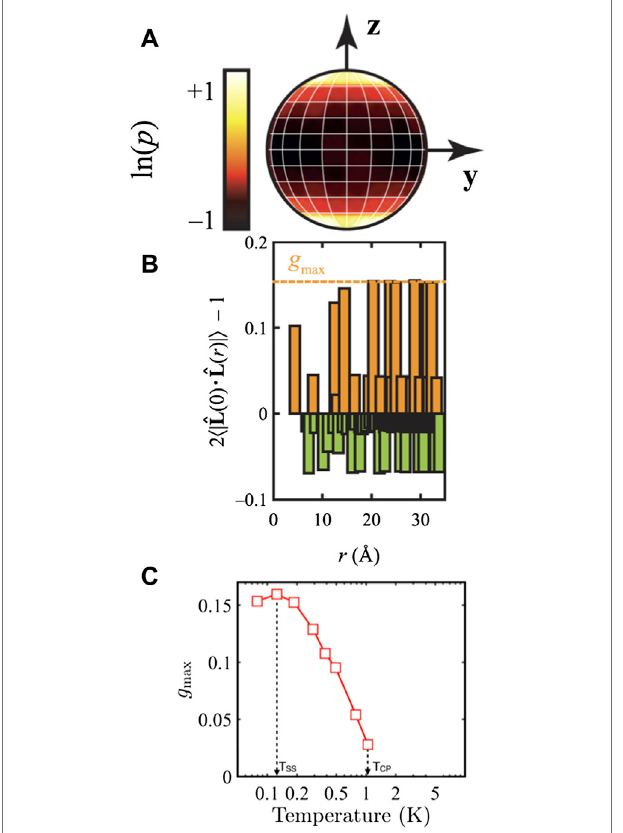
FIGURE 8 | (A) Stereographic projection of the logarithmic probability distribution function of the normalized 10-spin directors and (B) the axial correlation function of normalized 10-spin directors calculated from the RMC con fi gurations [4] (C) Temperature dependence of the maximum axial correlation [20].